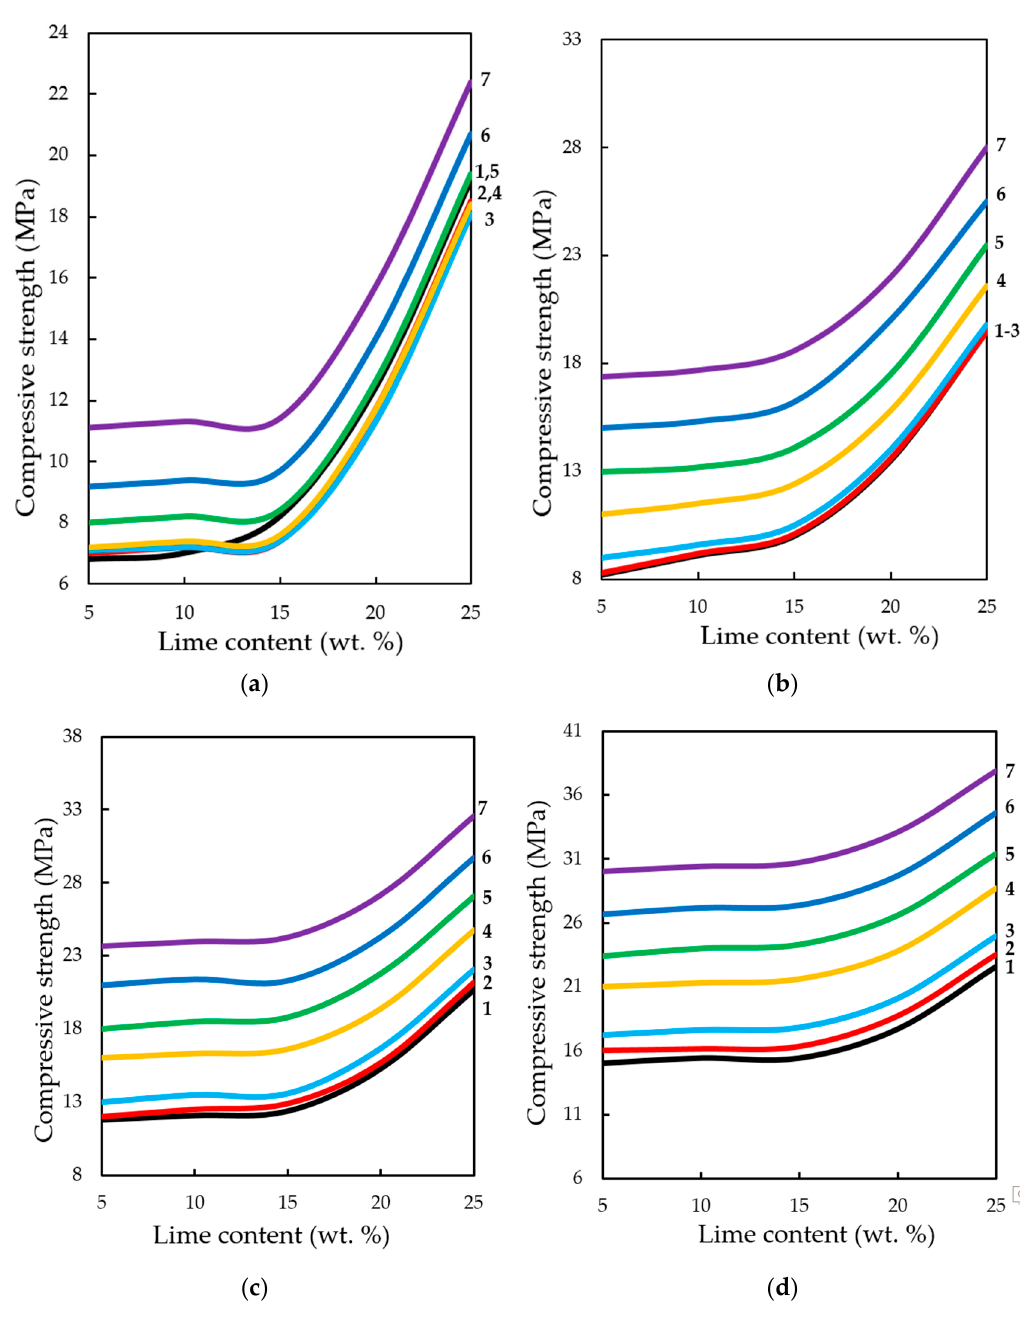
Figure 16. Variation in the compressive strength of testing samples manufactured at pressing pressure of: ( a ) 10; ( b ) 20; ( c ) 30; ( d ) 40 MPa. Samples carbonated by static method during 900 s, depending on the content of Ca(OH) 2 and concentration of СО 2 , %: 1— 10; 2— 20; 3 —30; 4— 40; 5 —50; 6 —60; 7 —65.